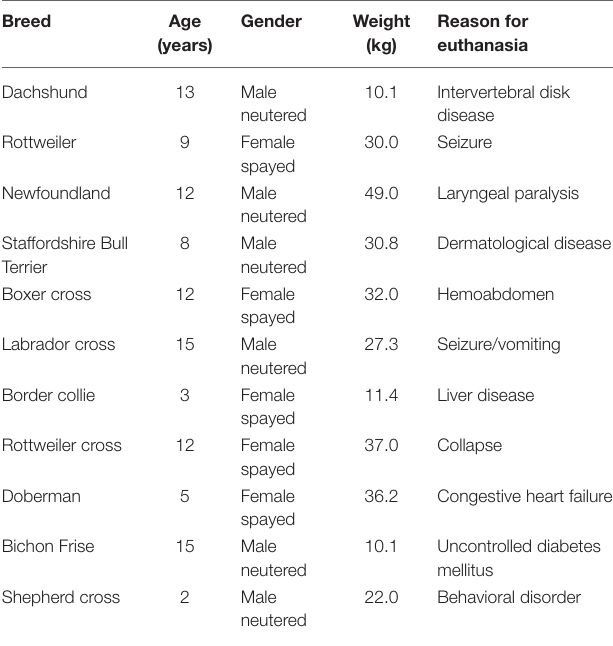
TABLE 1 | Subjects recruited into